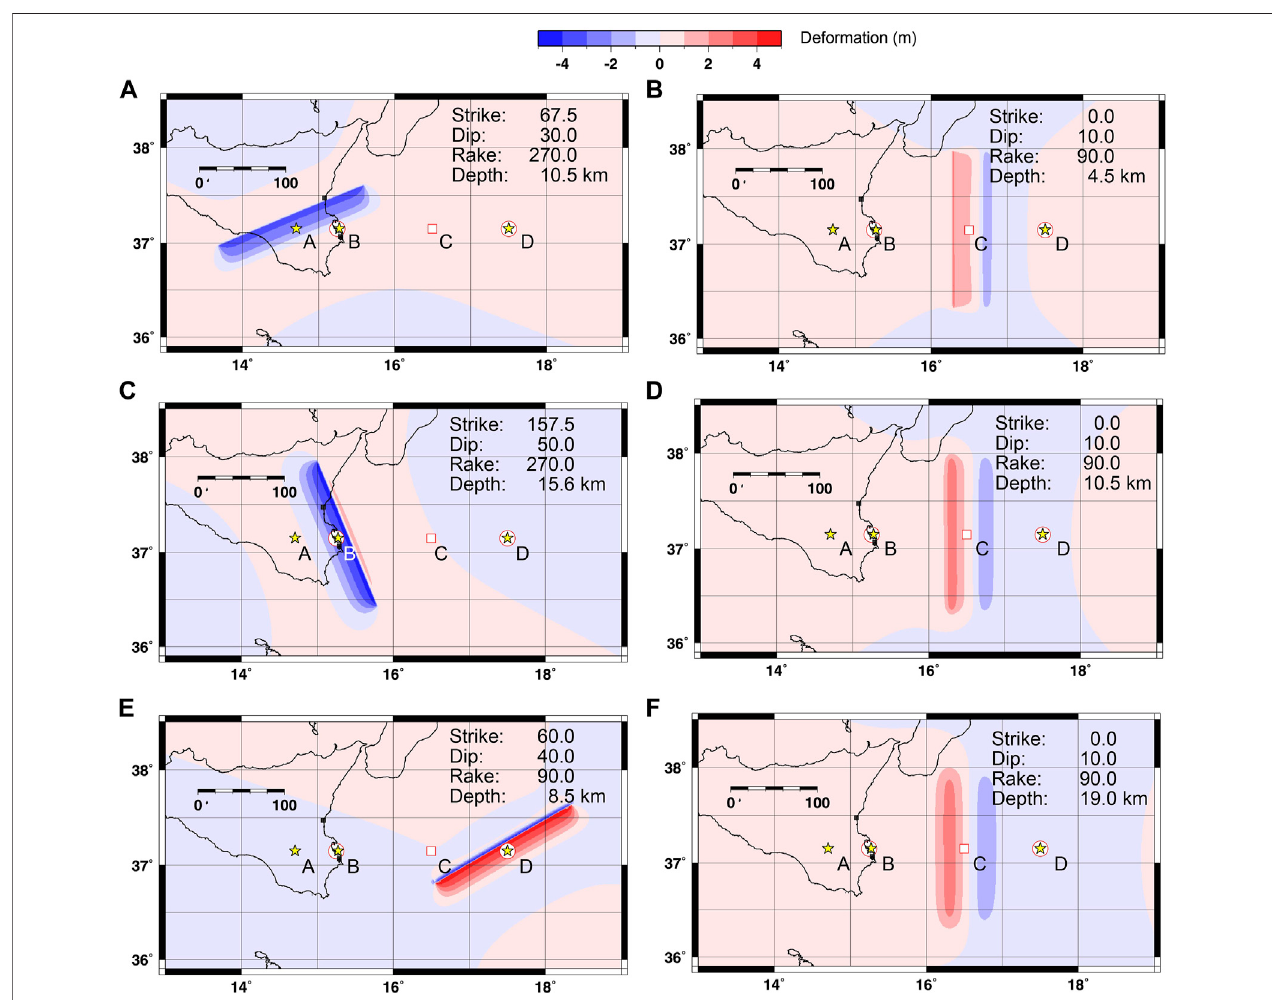
FIGURE 2 | Sea fl oor deformation using the Tsunami-HySEA code with Okada sources with strike, dip, rake, and depth parameters as indicated. All sources have length 183.5 km, width 38.1 km, and slip 7.5 m. Red and blue indicate a raising and a sinking of the ocean fl oor respectively. The Depth quoted here is the depth of the faultplanecentroid.Thesea fl oordisplacementsinpanels (A,C) correspondtoscenariosbasedonde fi nitionsintheNEAMTHM18model(subsequentlylabelledM1and M2 respectively). The remaining panels (B,D – F) show non-NEAMTHM18 scenario de fi nitions considered in this study.